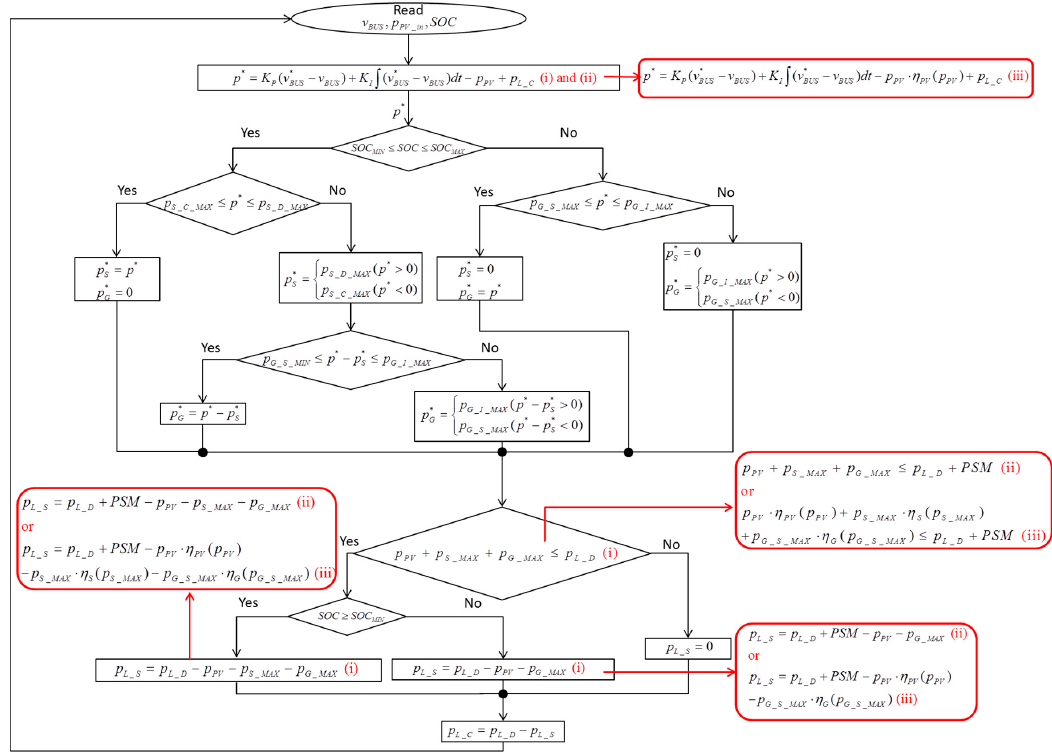
Figure 3. Power balancing flowchart.